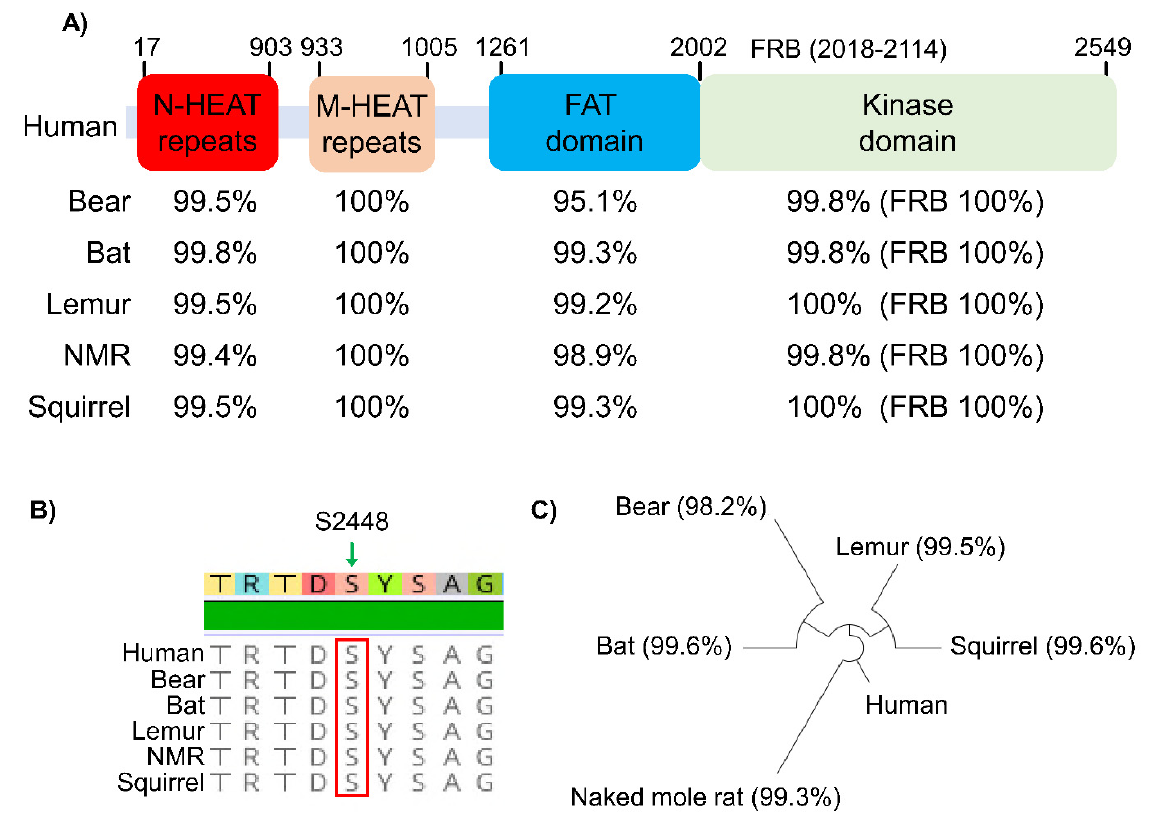
Figure 3. mTOR is highly conserved across mammals. ( A ) Diagram depicting domains of the human mTOR protein and relative conservation of each domain across different mammalian species. NMR: naked mole rat; N-HEAT: N-terminal Huntingtin, EF3, PP2A, and TOR1; M-HEAT: middle-HEAT; FAT: FRAP, ATM, TRRAP; FRB: FKBP12–Rapamycin Binding. Figure is adapted from Yang et al. 2017 [26]. ( B ) The key mTOR phosphorylation residue Ser-2448 and it flanking amino acids is 100% conserved across different mammalian species. ( C ) Lineage tree of mTOR protein between human, squirrel, lemur, bear, bat, and naked mole rat.